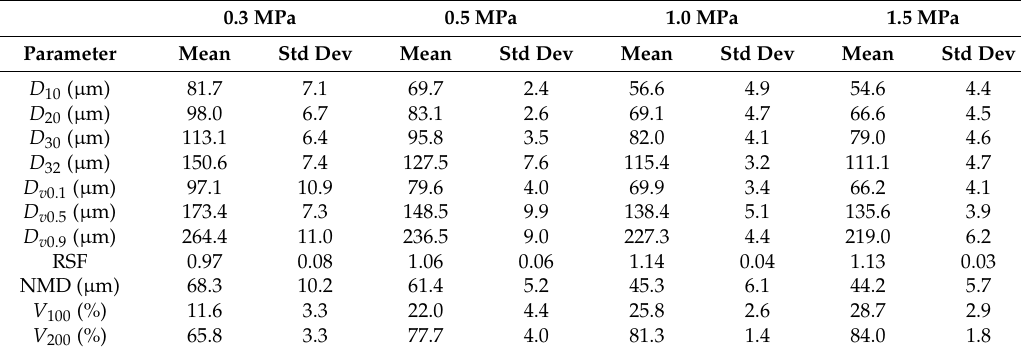
Table 2. Spray drop parameters in function of working